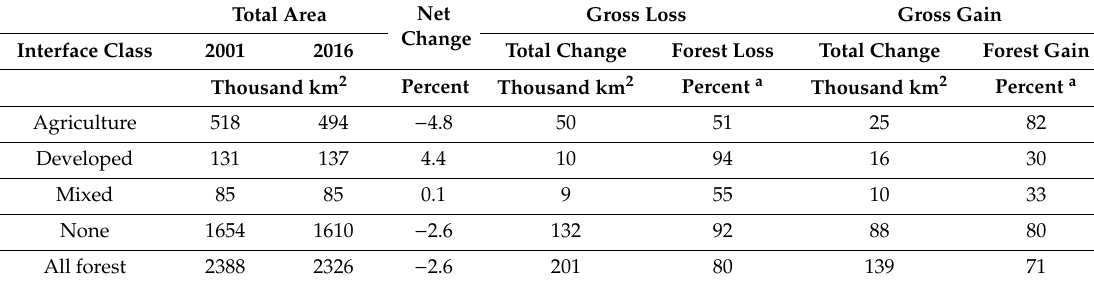
Table 6. Forest area change by interface class in the continental United States, 2001 to 2016. In addition to the percent of total gross change attributable to forest loss or gain (as shown), the percent of total gross change attributable to the shifting landscape mosaic can be obtained by subtraction from 100. Comparable statistics for nonforest areas are shown in Table 5.